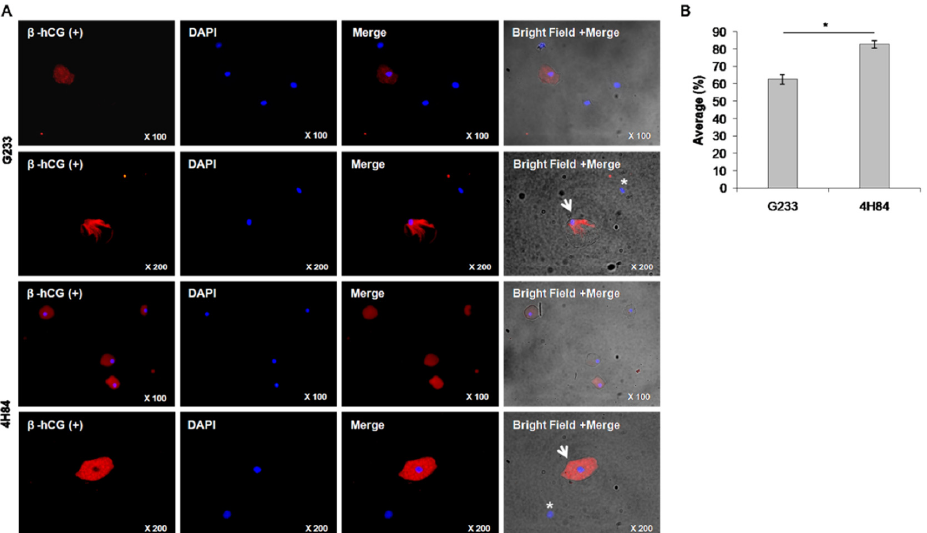
Figure 3. β -hCG expression between G233 and 4H84 clones by Immunofluorescence. ( A ) Comparison of expression patterns of HLA-G in trophoblast cells captured by G233 (top two rows) and 4H84 antibody (bottom two rows). More β -hCG expressing cells were identified in the cells captured by the 4H84 antibody. ( B ) β -hCG expression type of G233 and 4H84 clone by cell count percentage. (Arrow: extravillous trophoblast. Asterisks: immune cell).